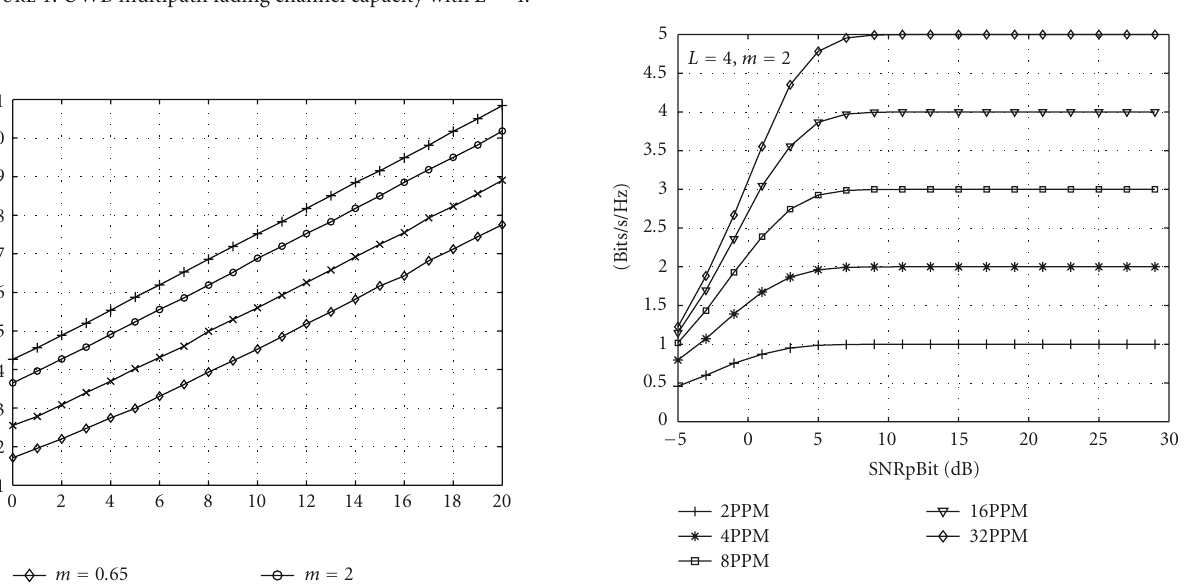
Figure 4: Capacity of a UWB system with PPM over a multipath fading channel with L = 4 and m =